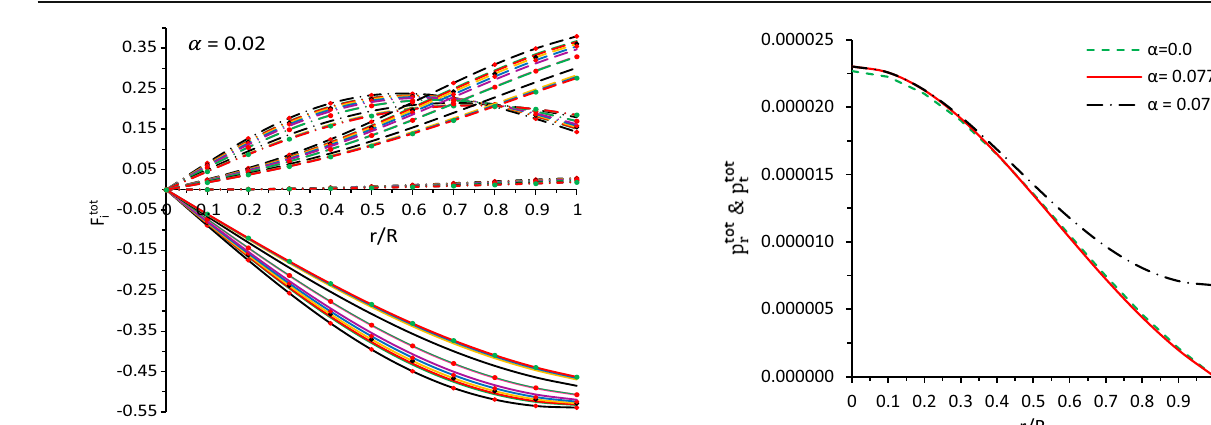
(long h Fig. 12 The behavior of total radial and tangential pressures ( p tot r and p tot t ) versus radial coordinate r / R by taking the numerical values of the constants a = 0 . 003, b = 0 . 0000053, β = 1 . 1, and γ = − 0 . 001. The description of the figure as follows: (i) the small dash green curve for p ( r ) = p tot r ( r ) = p tot t ( r ) corresponding to α = 0 . 0, since α = 0 . 0 leads an isotropic charged matter distribution, (ii) solid red curve for p tot r ( r ) corresponding to α = 0 . 077, and (iii) black long dashed-dot curve for p tot t ( r ) for α = 0 . 077